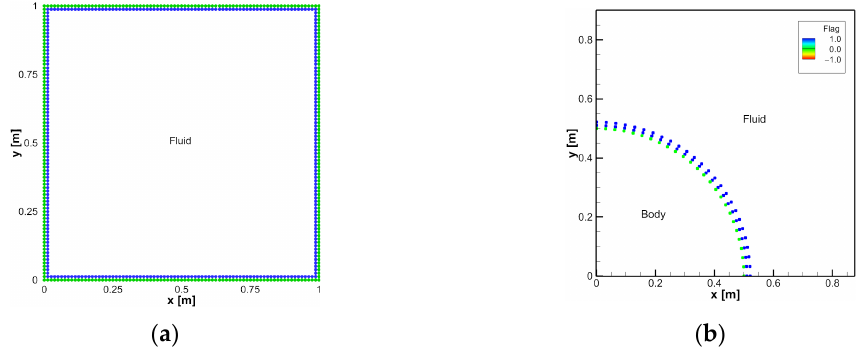
Figure 2. Boundary points (green) and their corresponding points (blue) for imposing boundary conditions in the case of ( a ) outer and ( b ) wall boundaries.